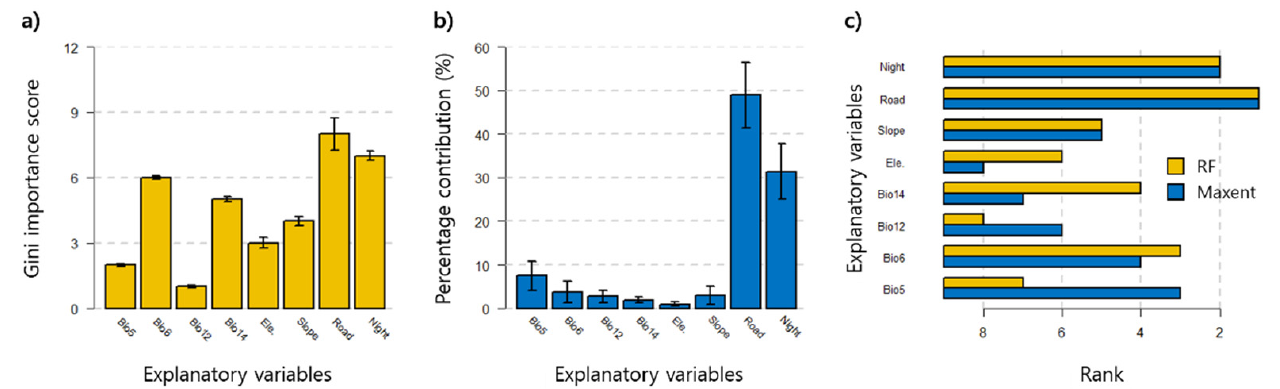
Figure 4. Variable importance in the RF model ( a ) and the MaxEnt model ( b ) and importance ranks ( c ) to predict the occurrence of WCSBs. The bars and error bars represent the mean and standard error of each variable. The abbreviation of environmental variables is the same as in Figure 3.